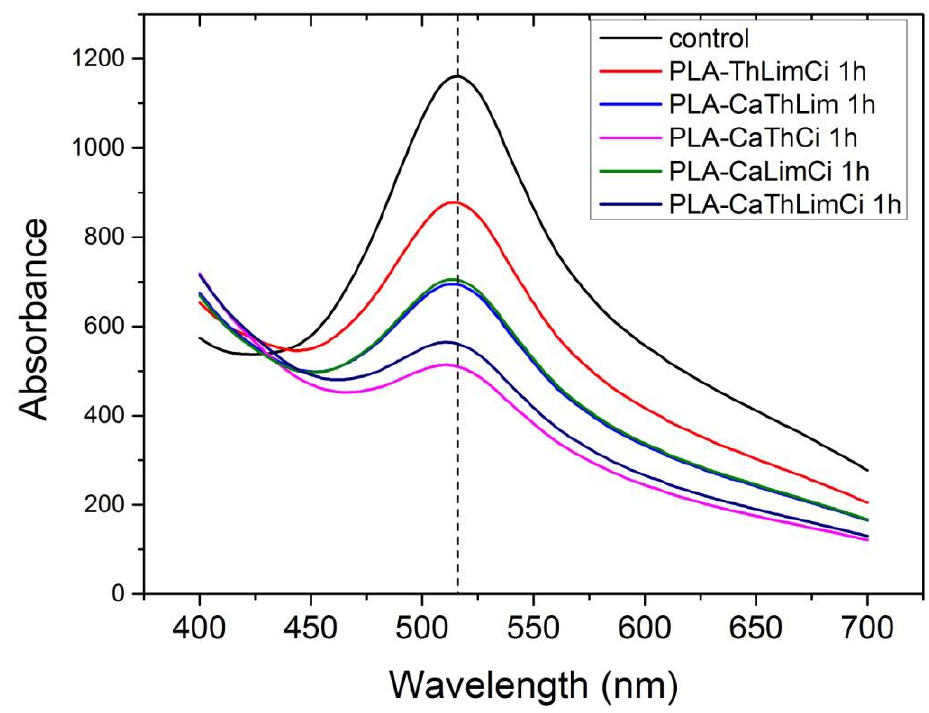
Figure 14. Comparative UV spectra of all ternary composites of PLA and the quaternary after 1 h in DPPH solution.